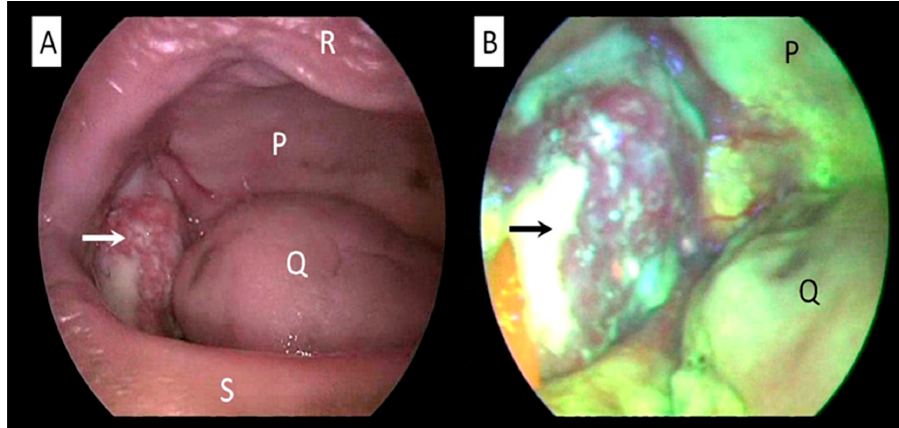
Figure 4. Oral cavity examination of a patient with oral cavity cancer using white-light ( A ) and autofluorescence mode ( B ). Abnormal mucosa around the cancerous area is clearly seen as autofluorescence loss compared with the surrounding normal healthy mucosa. An arrow indicates cancerous mass arising from buccal mucosa. Structure P: hard palate, Q: tongue, R: upper lip, S: lower lip (Figure is from author’s own collection).